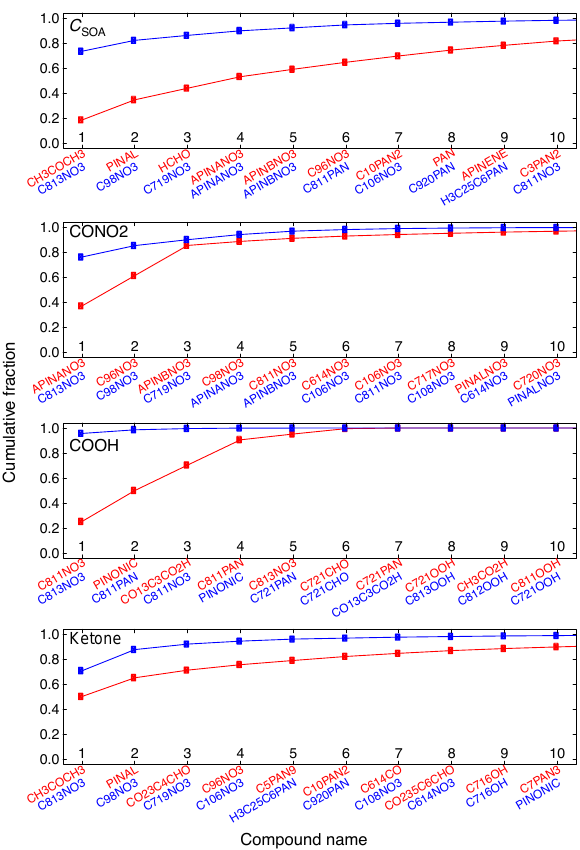
Figure 6. Cumulative contribution (as a fraction of total) of each compound to the overall C SOA mass and abundance of different FG fragments for the APIN-hNO x simulation. Compounds are ar- ranged in order of decreasing contribution (i.e., the first compound contributes most) for each phase. Contributions to the aerosol phase are shown in blue and the gas phase in